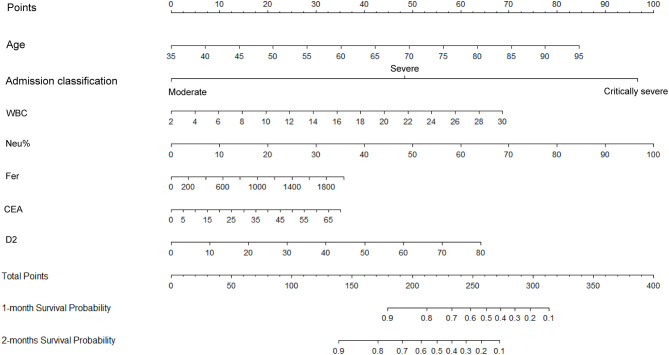
Construction of a nomogram to predict the overall survival of patients with COVID-19 comprising CEA levels and other significant indicators. The points total are located on the Total Point axis, and a vertical line is traced downward to the survival axes to predict the likelihood of an OS of 1 or 2 months. COVID-19, Coronavirus disease 2019; CEA, Carcinoembryonic antigen.